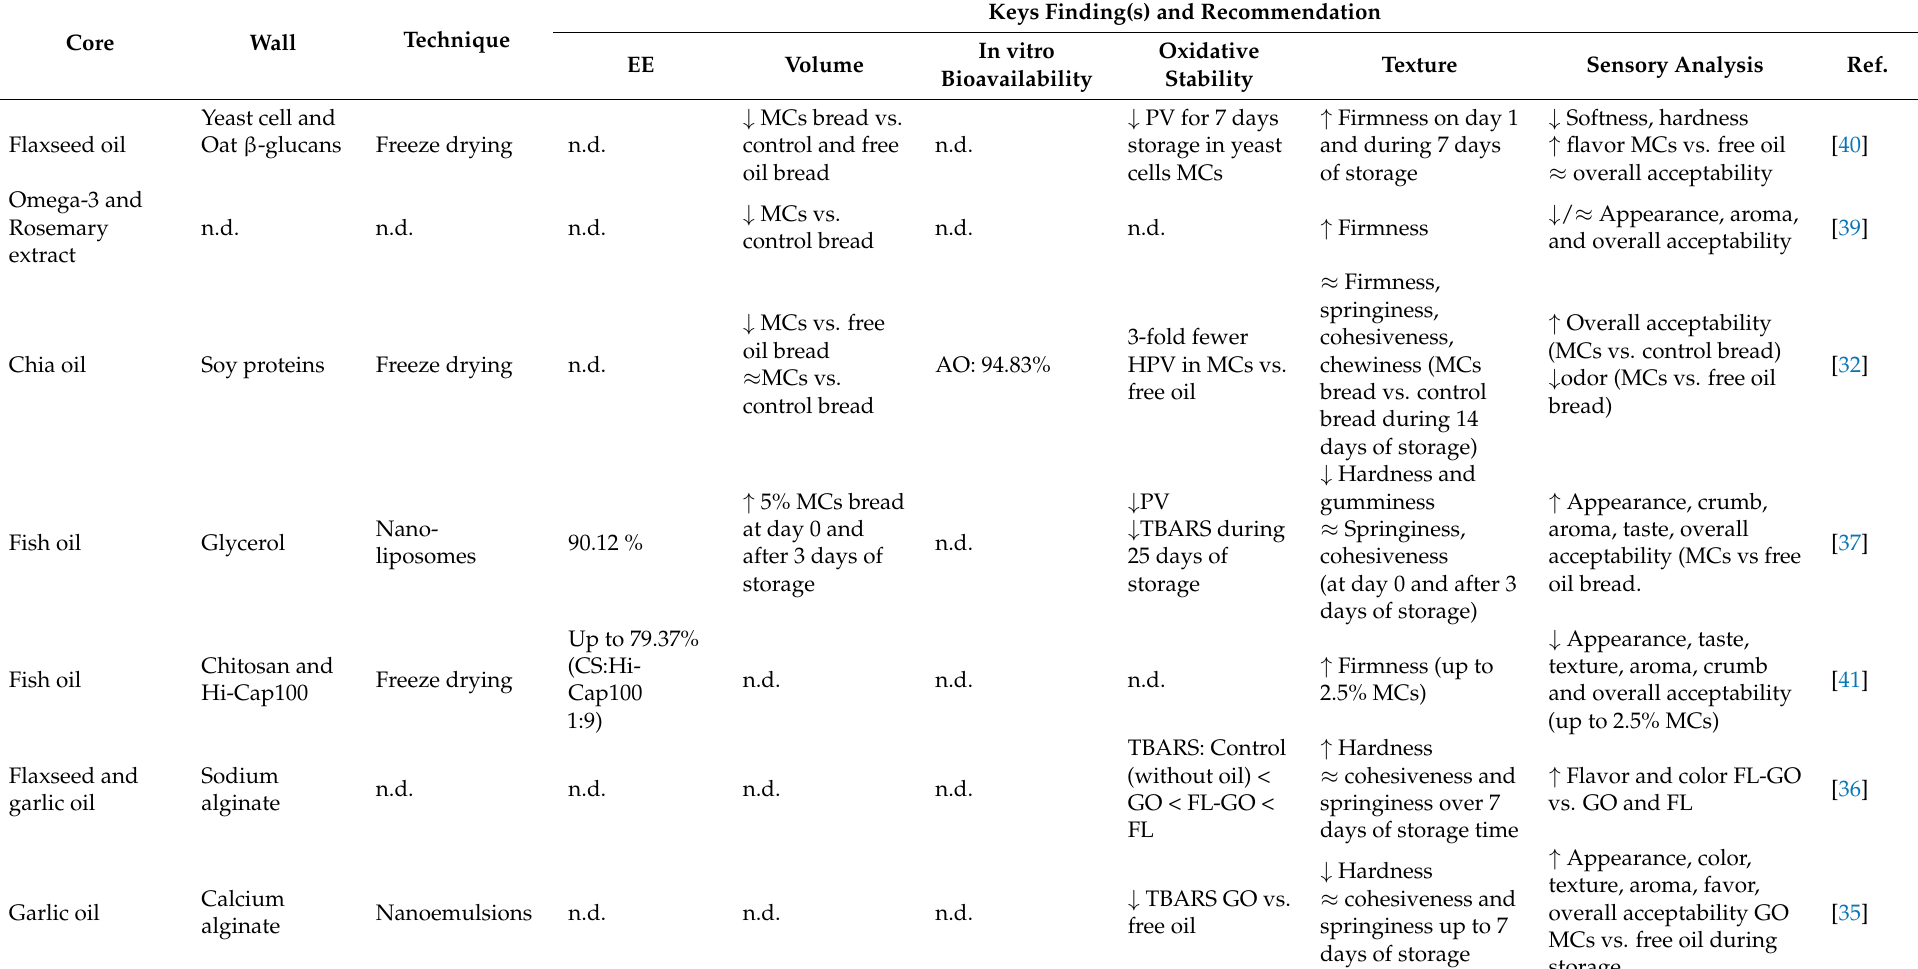
Table 3. Encapsulation of fatty acids sources for bread